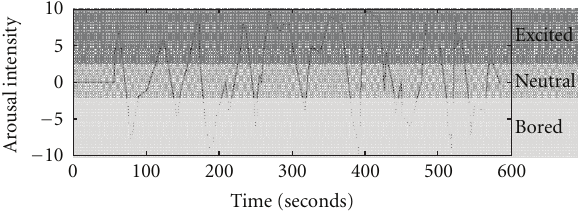
Figure 2: Data labeling for the active arousal experiment. The FEELTRACE is a continuous arousal